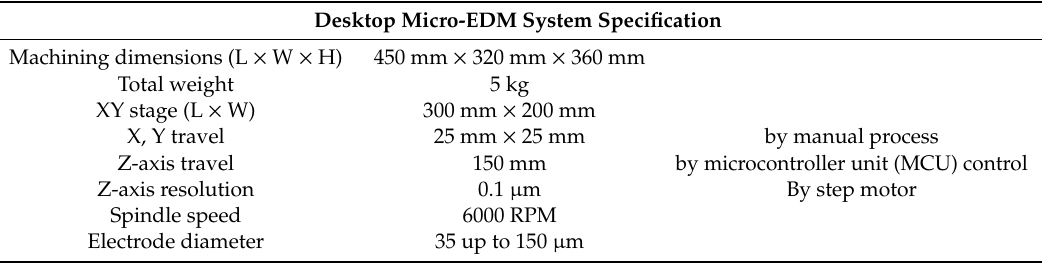
Table 1. Main specification of the desktop micro-EDM system.